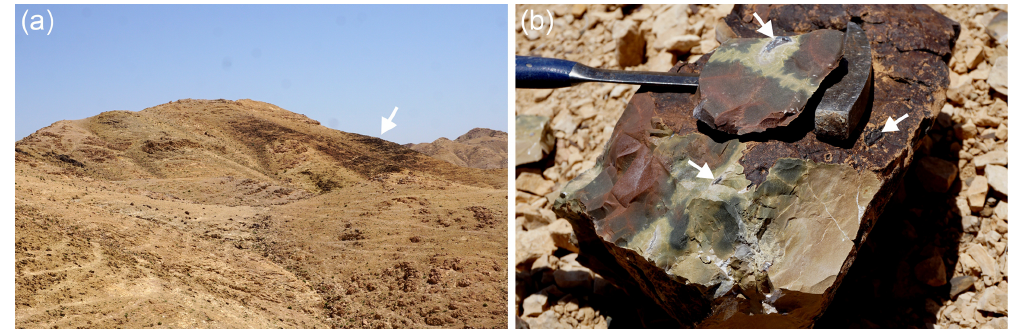
Figure 3. (a) Wollastonite–gehlenite hornfels (arrow) is distinguished by a dark colour against the background of light-coloured rocks of the Hatrurim Complex altered during low-temperature processes. (b) Dense and hard hornfels contains small segregations of hematite (arrows), in some of which has been found kahlenbergite in light-brown fragments of the rock.